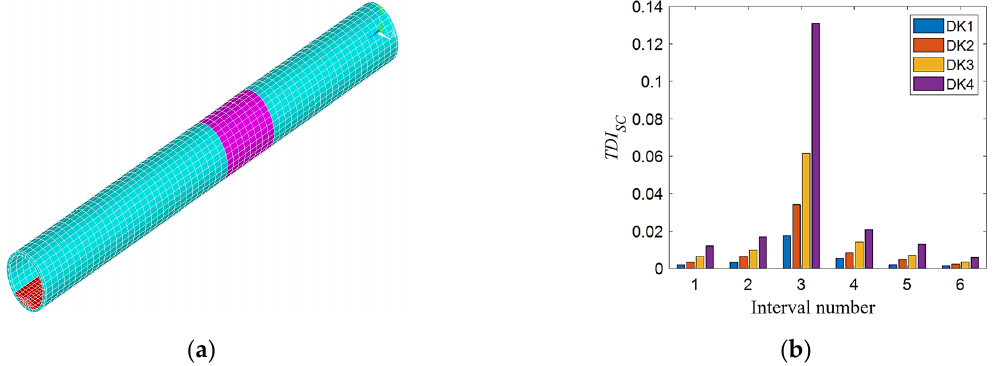
Figure 7. TDI SC index verification for different degrees of single stiffness damage: ( a ) single stiffness damage tunnel model in the third interval and ( b ) TDI SC at different degrees of single stiffness damage.